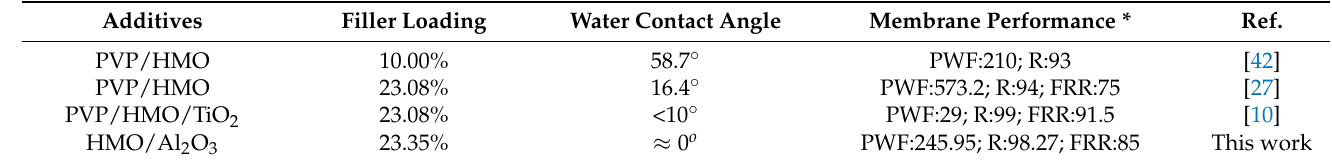
Table 2. Summary of the performance of additives in PES membranes for oily wastewater treatment application.